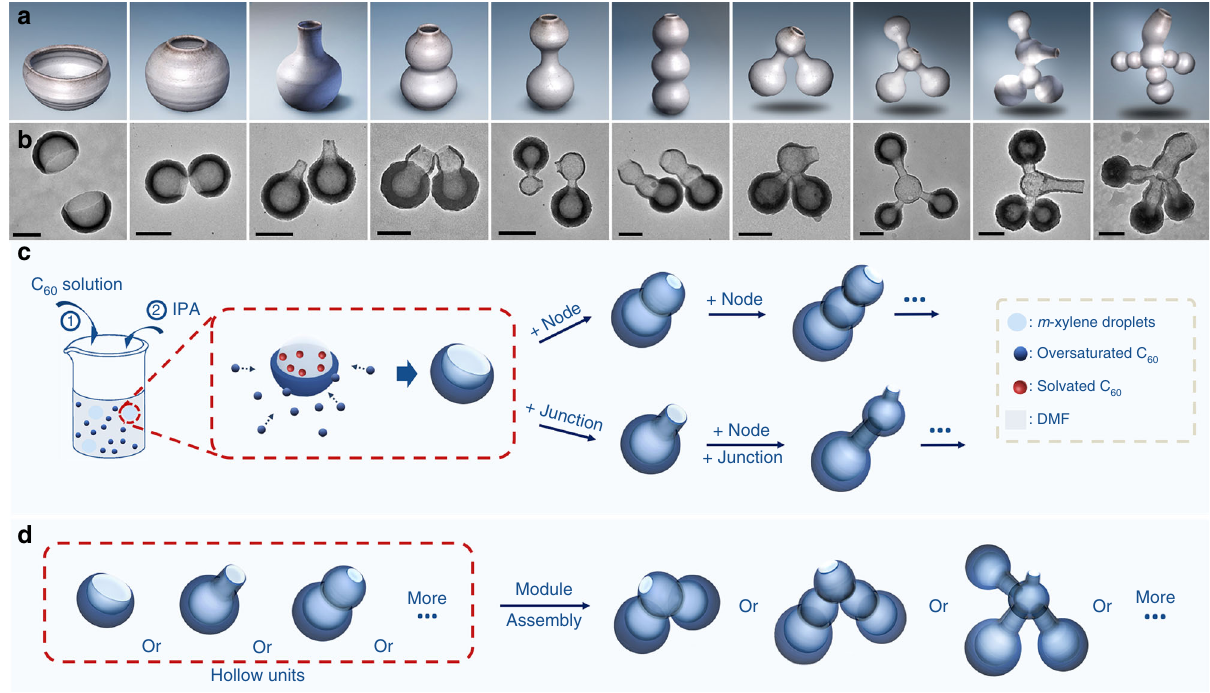
Fig. 1 Schematics illustrating the concept and design. a Models of pottery, and b transmission electron microscopy (TEM) images of their corresponding nanostructures created with nanopottery. c Schematics illustrating the synthesis of different hollow units, and d connection of hollow units. Scale bars are 200